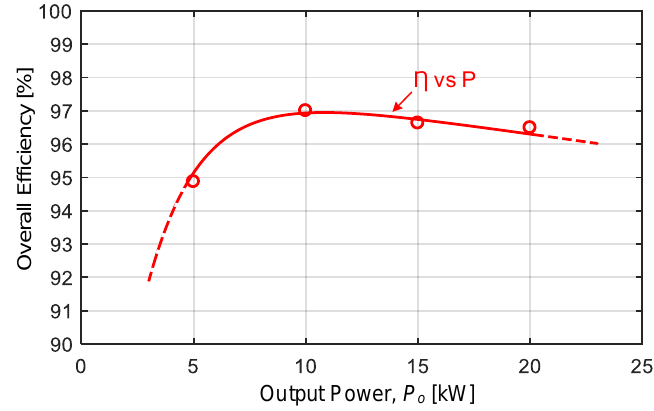
Figure 31. Efficiency of all SiC grid-connected PV supply against output power, η = [ P o /P i ] × 100 (experimental values of P o and P i are obtained as described in the caption of Figure 29).